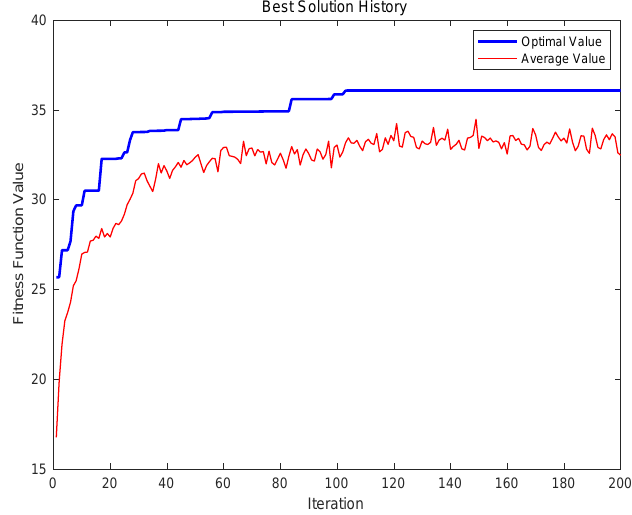
Figure 3. Evolution results of PGA with 28